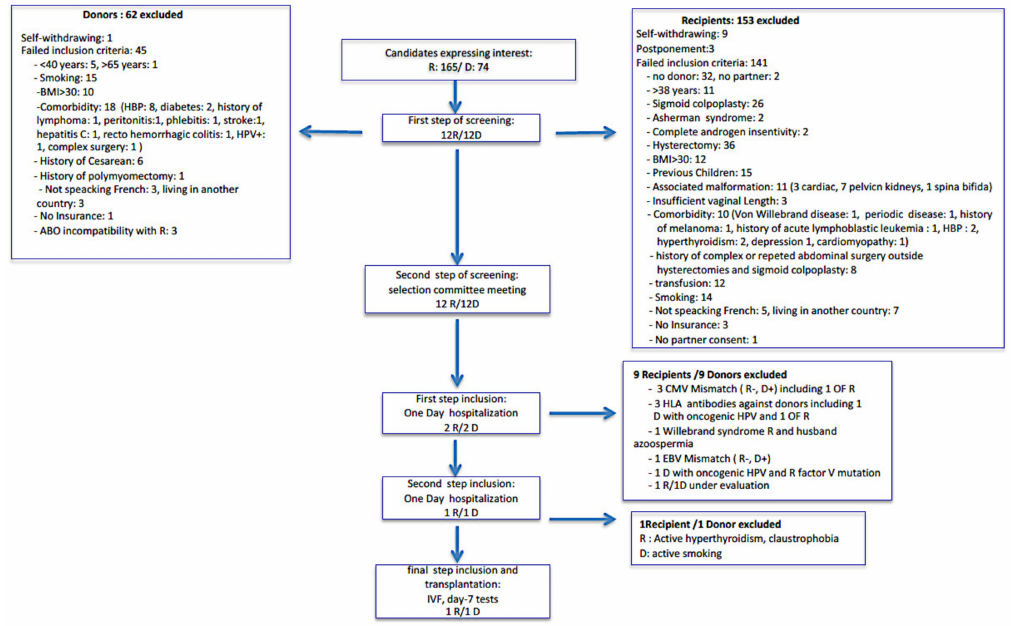
Figure 1. Results of screening and inclusion process for candidates. OF: ovarian